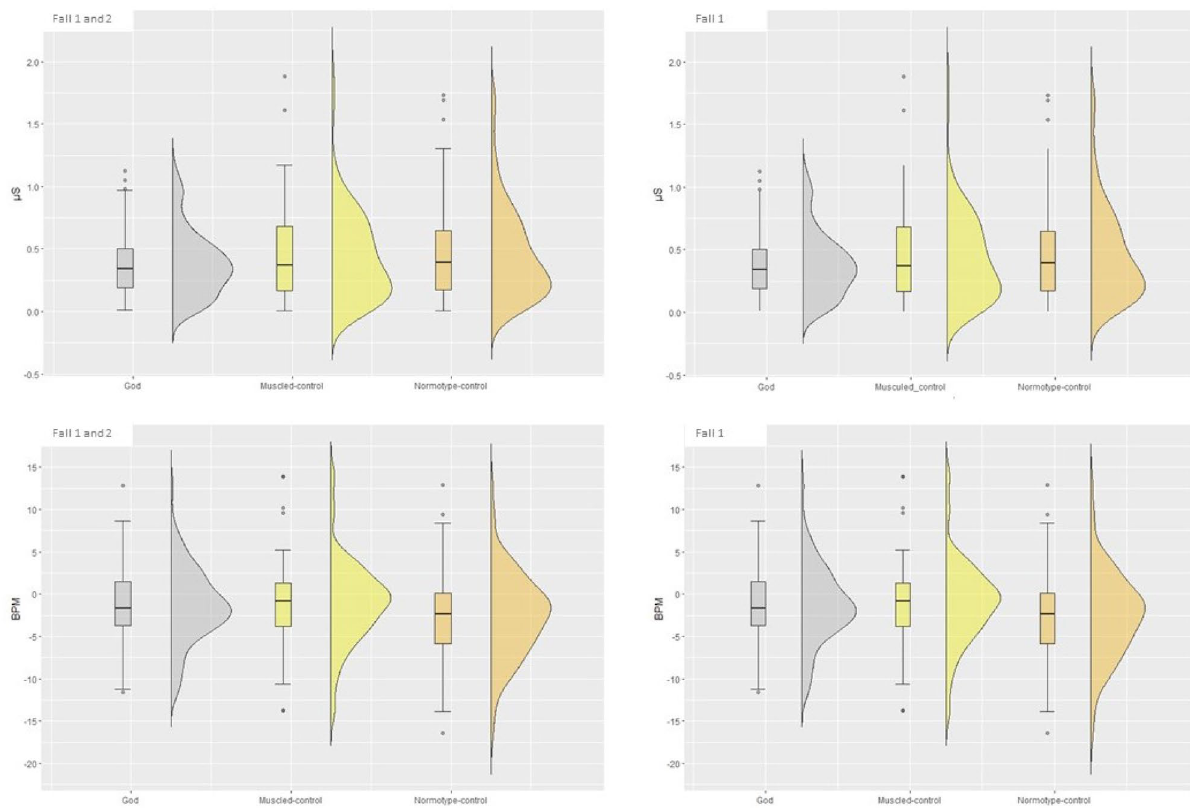
Figure 5. Physiological Measures: The box and violin plot show SCR (Upper part) and HRD (Lower part) recordings as a function of the Avatar embodied (God-avatar, Muscled-control avatar, Normotype-control